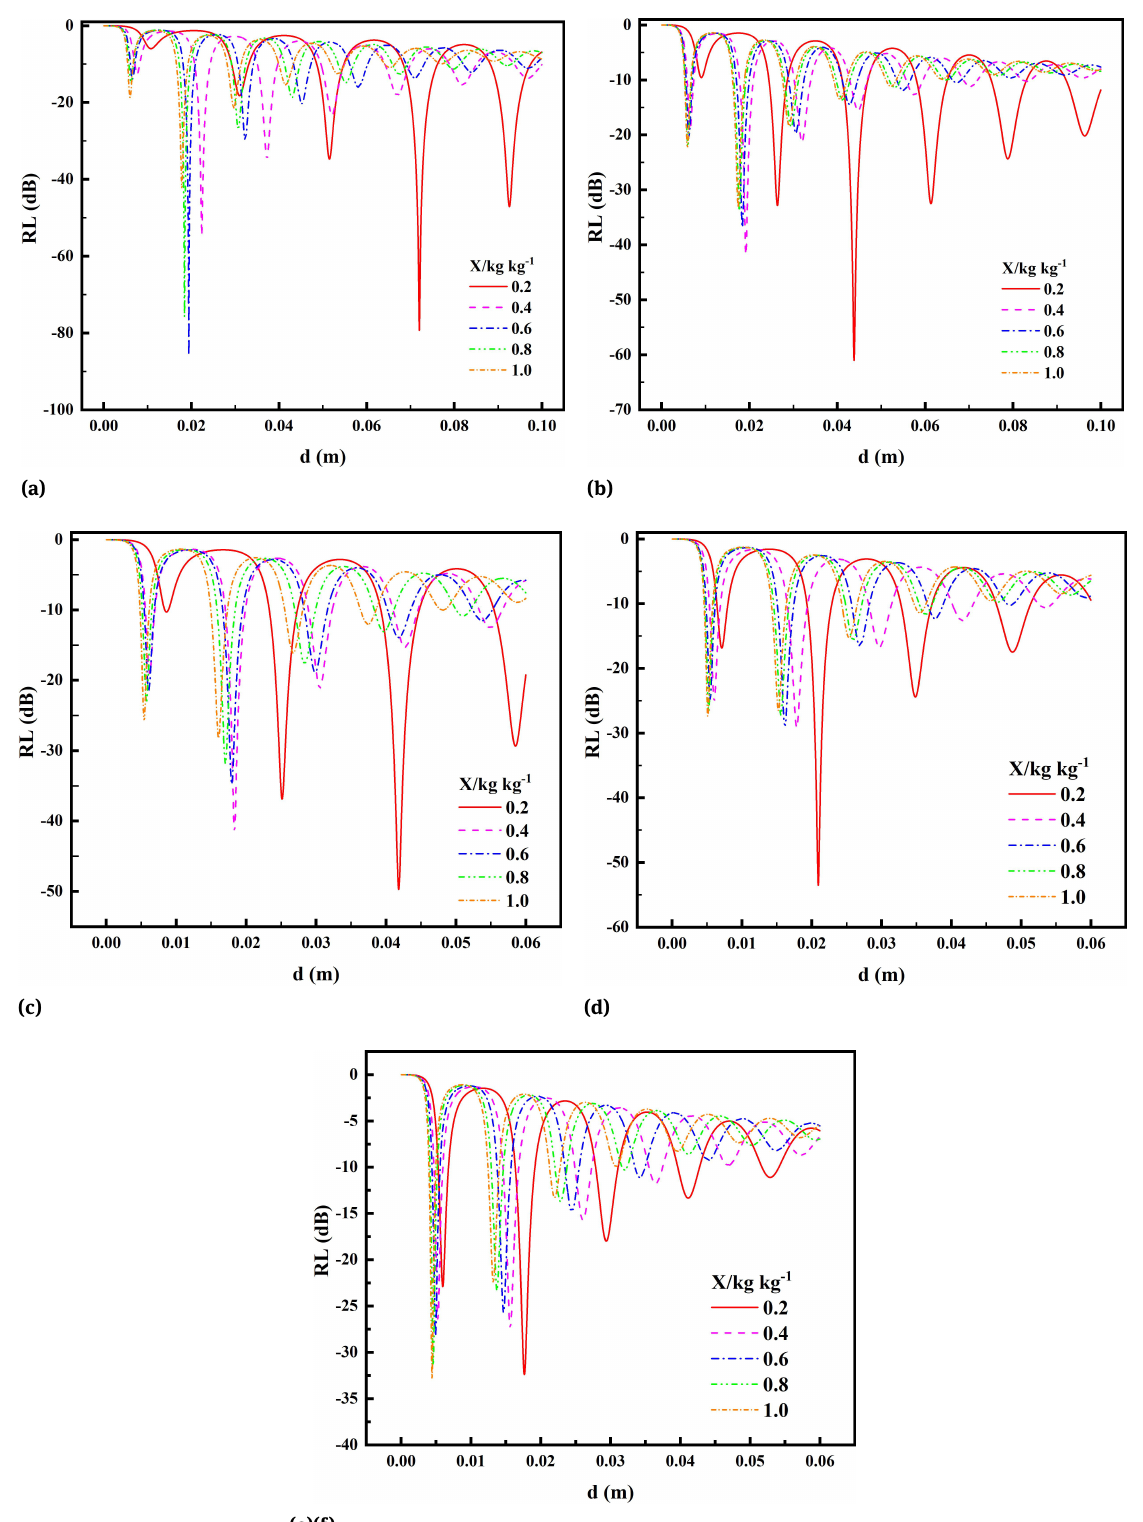
Figure 5: Moisture dependence (0.2, 0.4, 0.6, 0.8, 1.0 kg kg −1 ) of reflection loss of paracetamol as the thickness varies from 0 to 1.0 m for temperatures: (a) 20 ∘ C, (b) 30 ∘ C, (c) 40 ∘ C, (d) 50 ∘ C, (e) 60 ∘ C, (f) 70 ∘